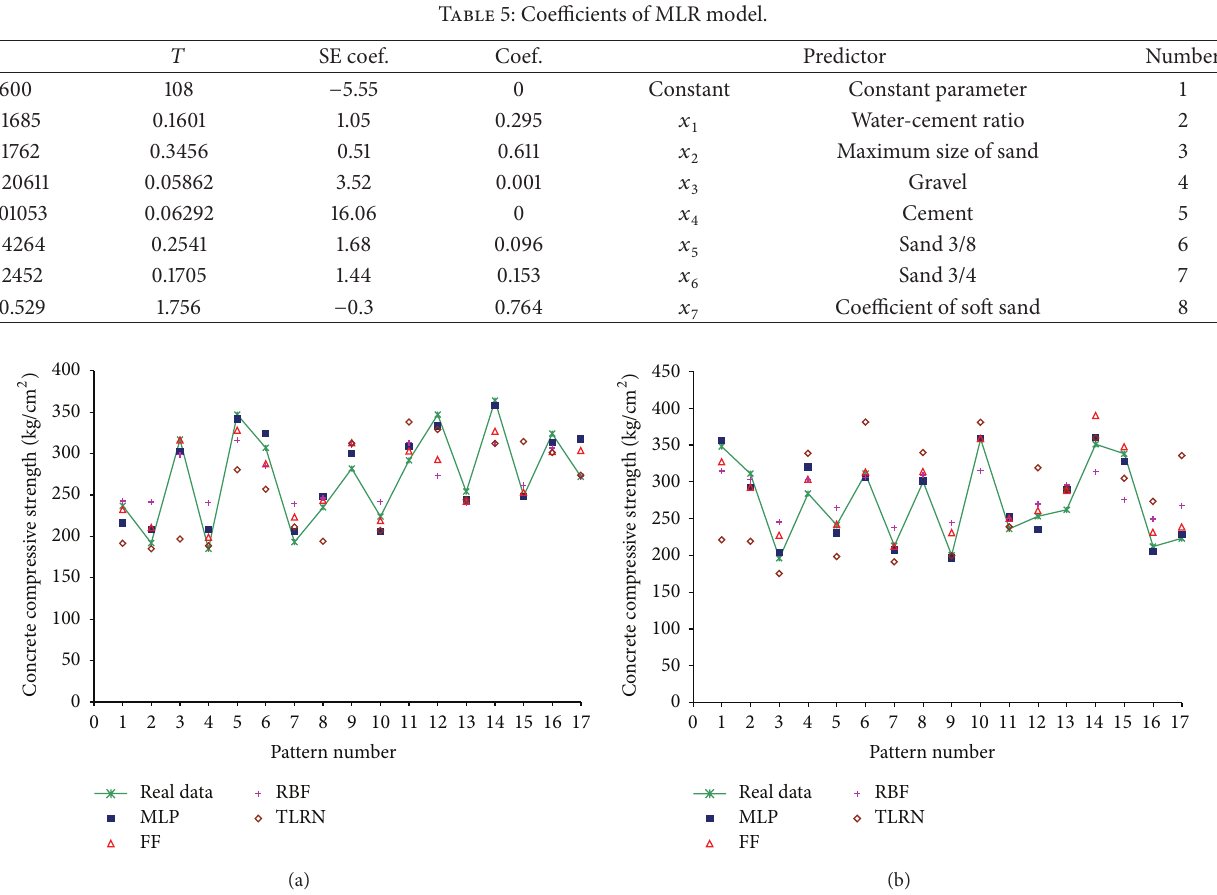
Figure 3: Comparison of observed compressive strength of concrete calculated by EANN models in testing (a) and validation (b) stage.